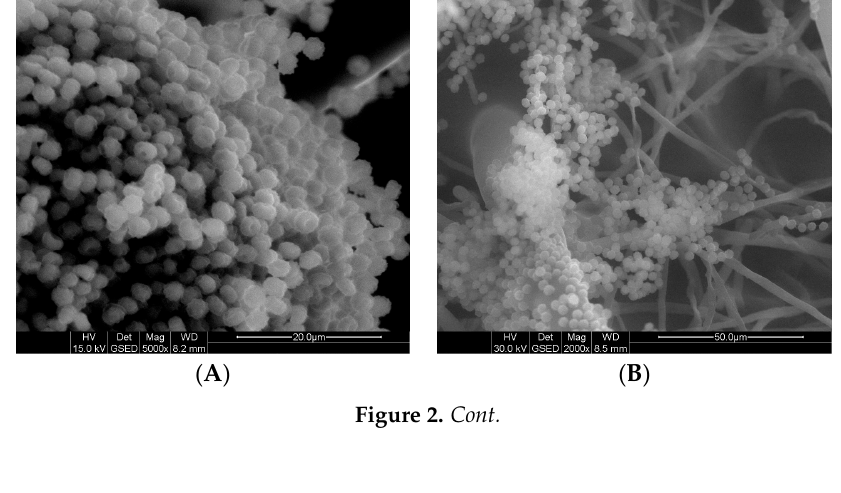
Table 4. Effect of exogenous ergosterol on MICs of cationic and neutral gemini surfactants for A. brasiliensis